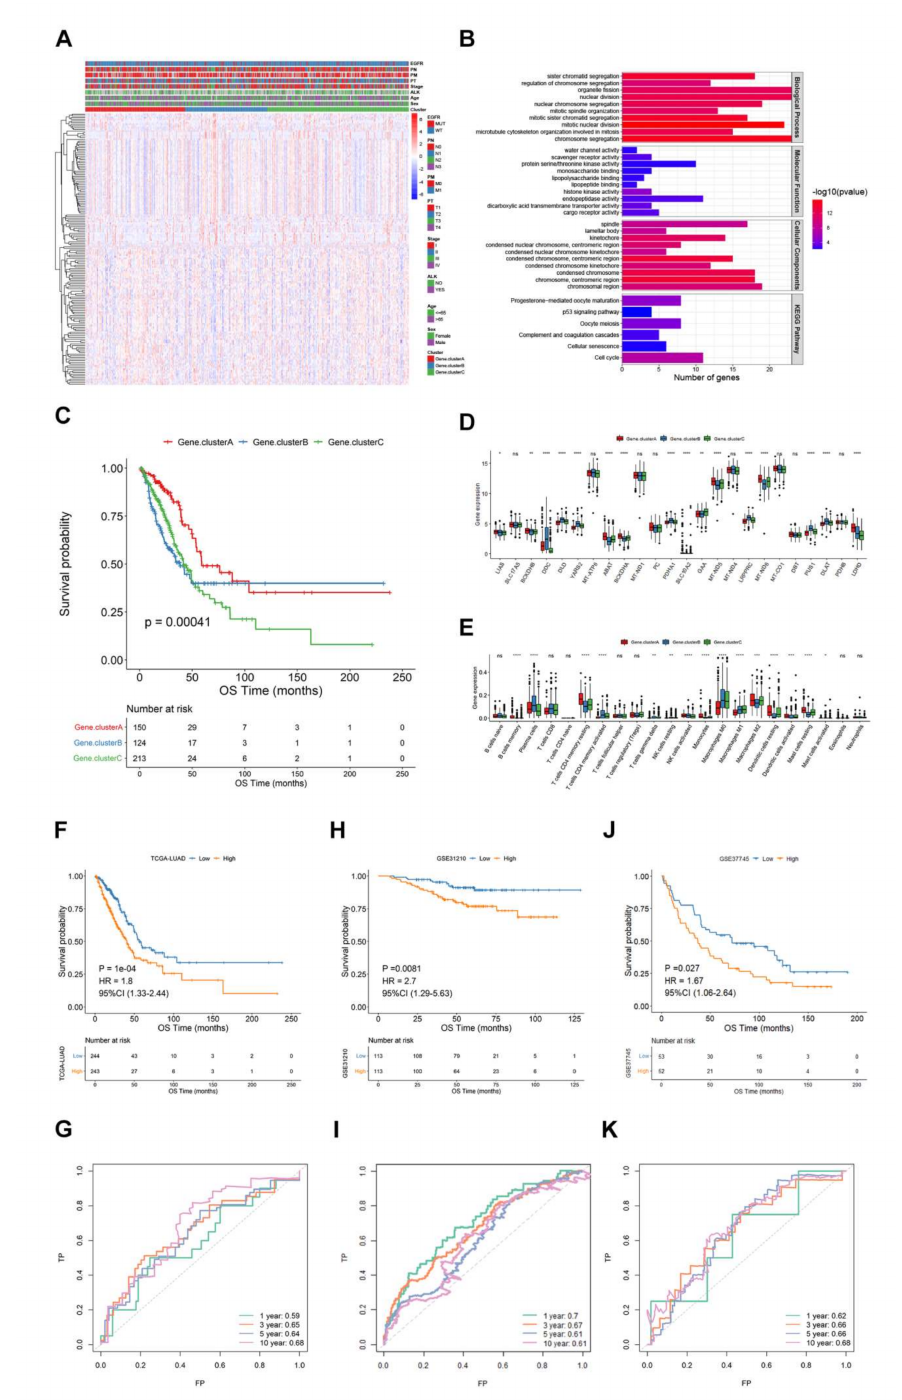
Figure 4. Lactate metabolism related score model construction. ( A ) A total of three gene clusters derived from the two lactate clusters based on 162 different expressed genes. ( B) Functional enrich- ment analysis of different expressed genes. ( C – E ). OS(C), lactate gene expression ( D ) Immune cells ( E ) of three clusters. ( F , G ): High and low risk group divided by the lactate score model showed an OS difference ( p = 0.0001, HR = 1.8). ( H – K ). The OS and AUC curves was depicted to reflect the validation of the model by the GSE31210 (( H , I ), p = 0.0081, HR = 2.7) and GSE37745 (( J , K ), p = 0.027, HR =